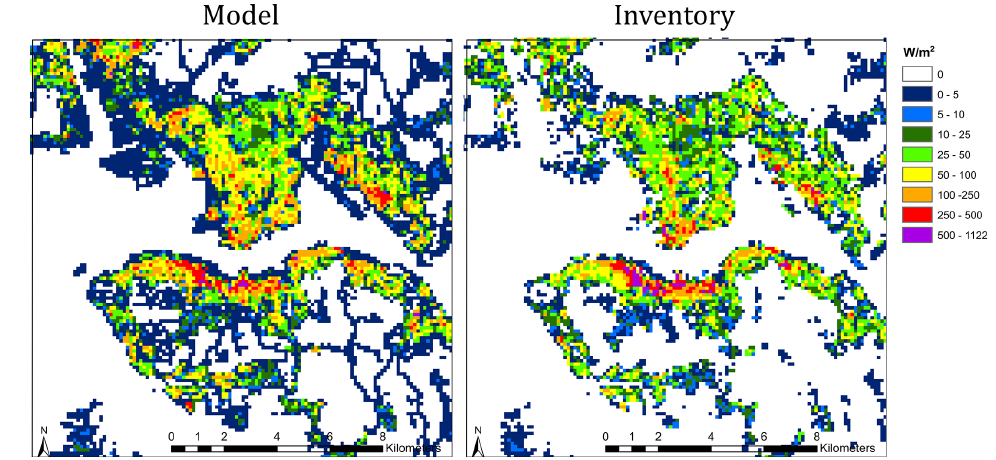
Figure 12. Anthropogenic heat flux due to building energy consumption in